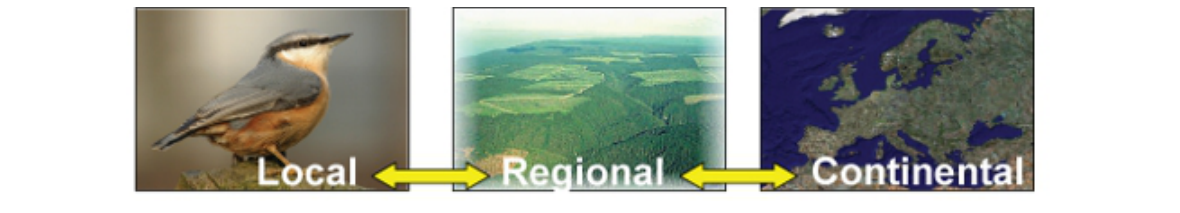
Fig. 1 . The relation between species, habitats and earth observation data (http://www.EBONE.wur.nl/ UK/Project+Work+Packages/WP5+Inter-calibration/, accessed March 16,